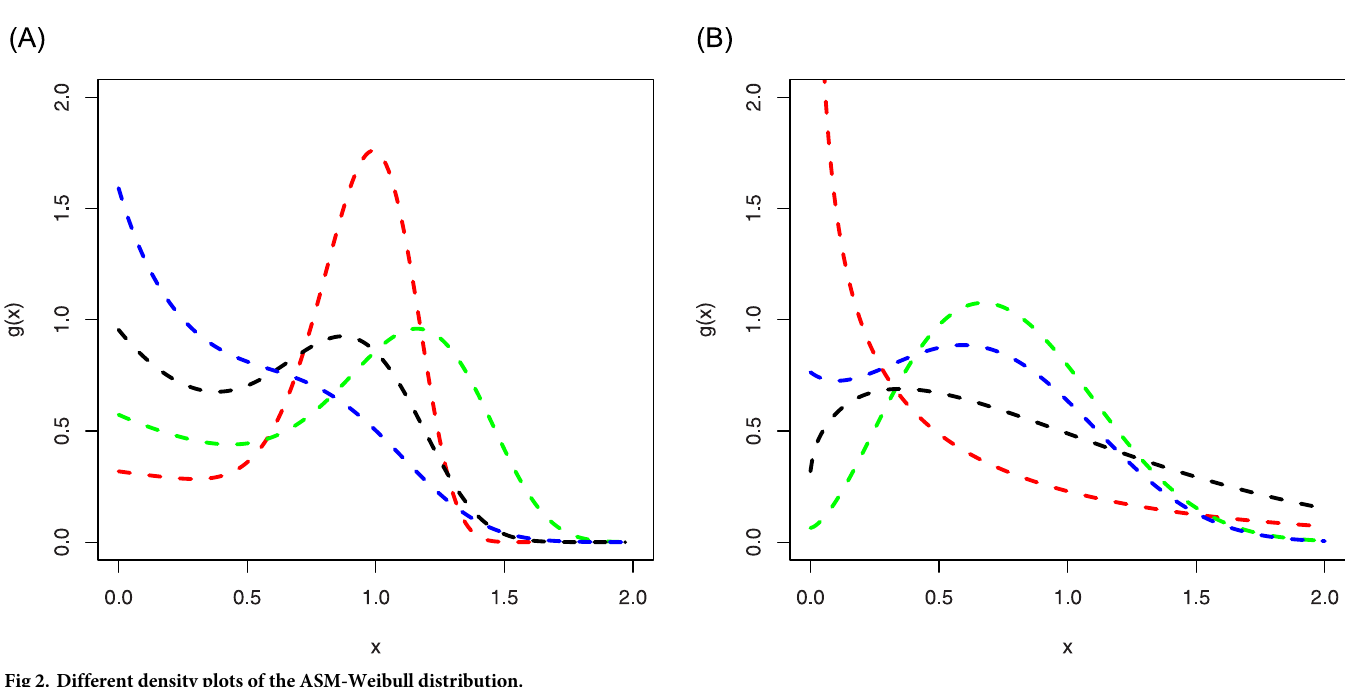
Fig 2. Different density plots of the ASM-Weibull distribution.